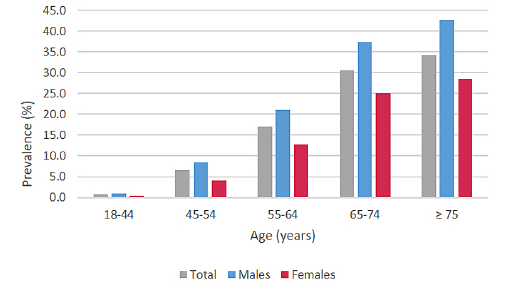
Figure 1: Prevalence of patients with ≥ 1 filled prescription of any lipid-lowering drug in the year 2019 (n= 841682), by age and sex, extrapolated to the Swiss population